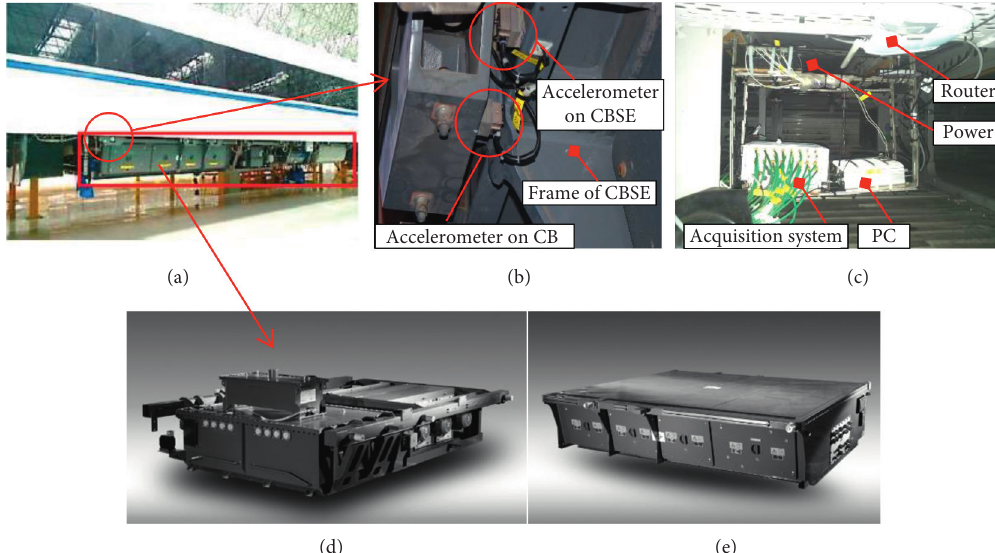
Figure 2: Field test for CRH380B: (a) CBSE under the car body chassis with cabin shield removed [10]; (b) accelerometers on CB and CBSE at the connection; (c) data-acquisition system on board; (d) CBSE traction transformer; (e) CBSE traction converter.